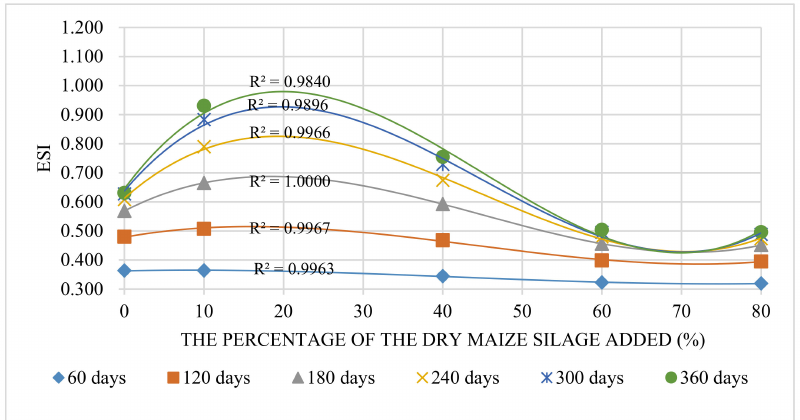
Figure 5. The trend of ESI change with different percentages of maize silage